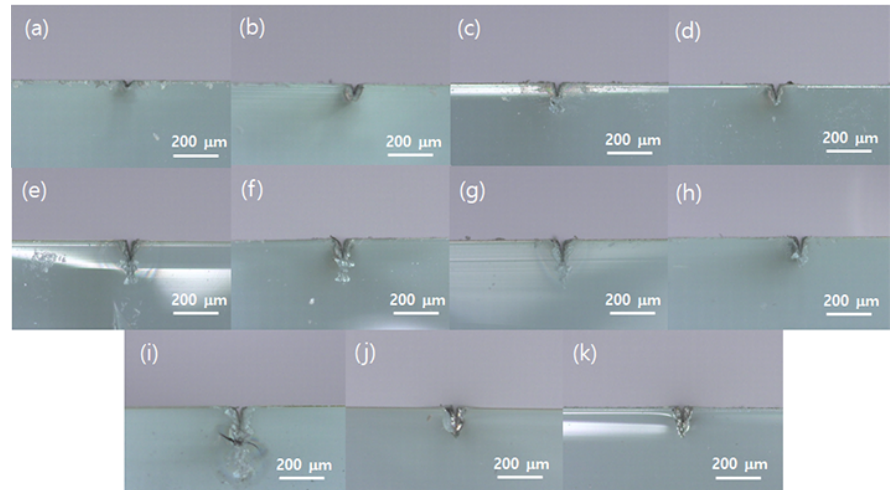
Figure 10. Depth and width of the groove as a function of the number of scans.